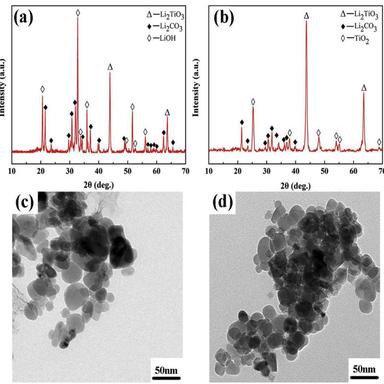
(aeb) XRD patterns and (ced) TEM images of Li4 and Li2 precursor powders synthesized by the hydrothermal method.